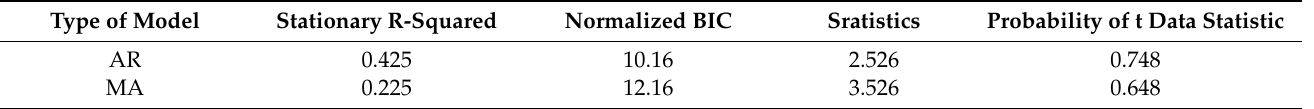
Table 4. Statistics of the Stationary R-squared and normalized BIC value.